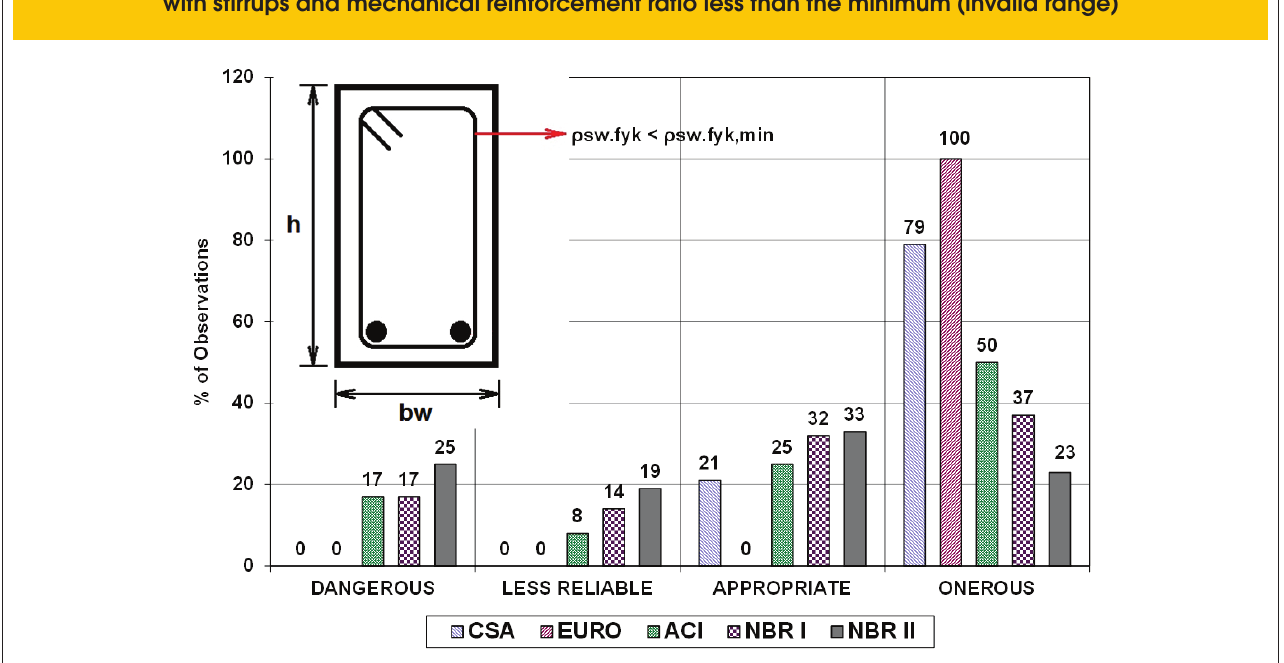
Figure 5 – Distribution of models results, according to the comparison criteria for elements with stirrups and mechanical reinforcement ratio less than the minimum (invalid